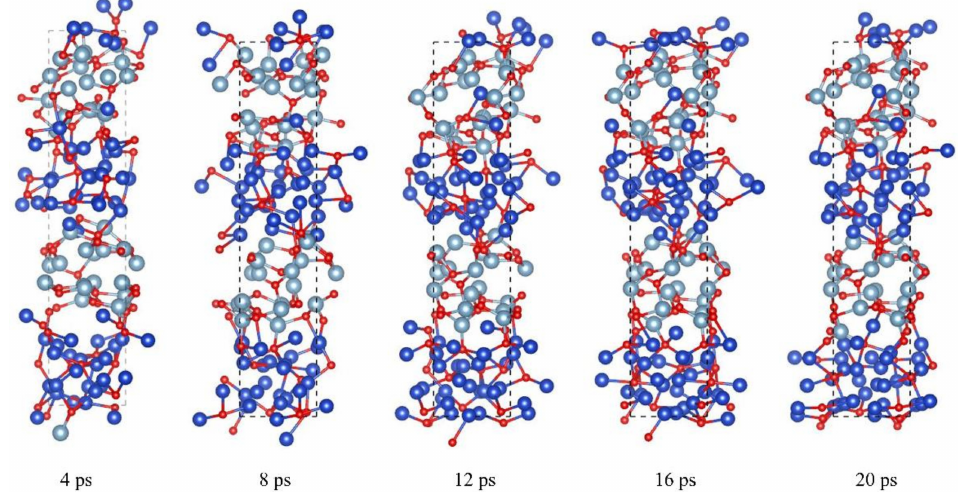
Figure 5. Structure changes of the nano Al /CuO energetic composite films with a two-modulation- period configuration during the preparation process (side view). The pale blue, blue, and red spheres represent Al, Cu, and O atoms,